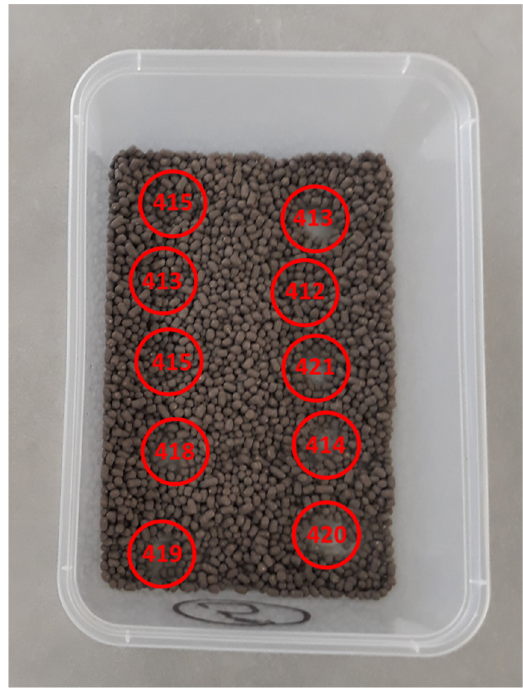
Figure 7. The mean tebuthiuron contents for the ten spatial replicates analysed. The numbers over each sample location provide the mean tebuthiuron content in mg/g.